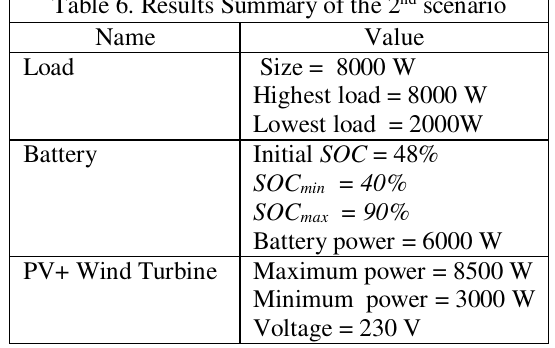
Table 6. Results Summary of the 2 nd scenario